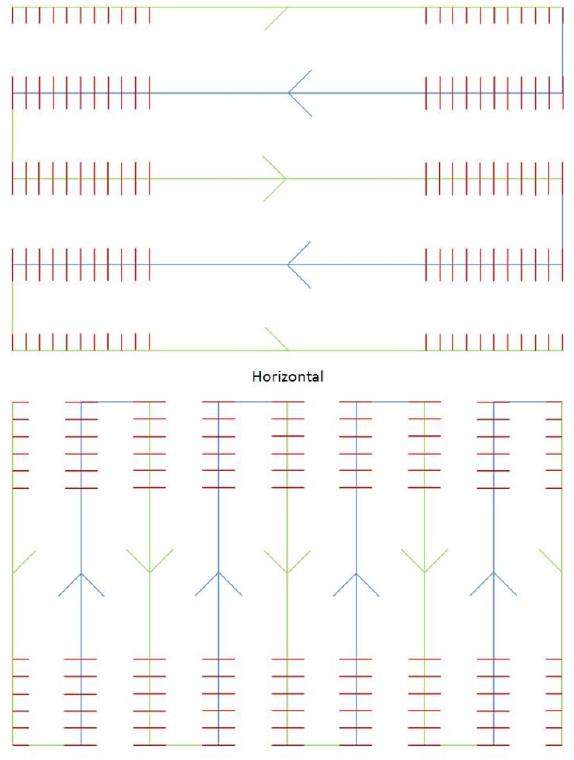
Figure 3: Stimuli for near-border testing. This is an extension on the initial stimuli with additional fixation points near the border, both for the horizontal and vertical lines. The additional target points are indicated by the intersection of the short red lines with the main